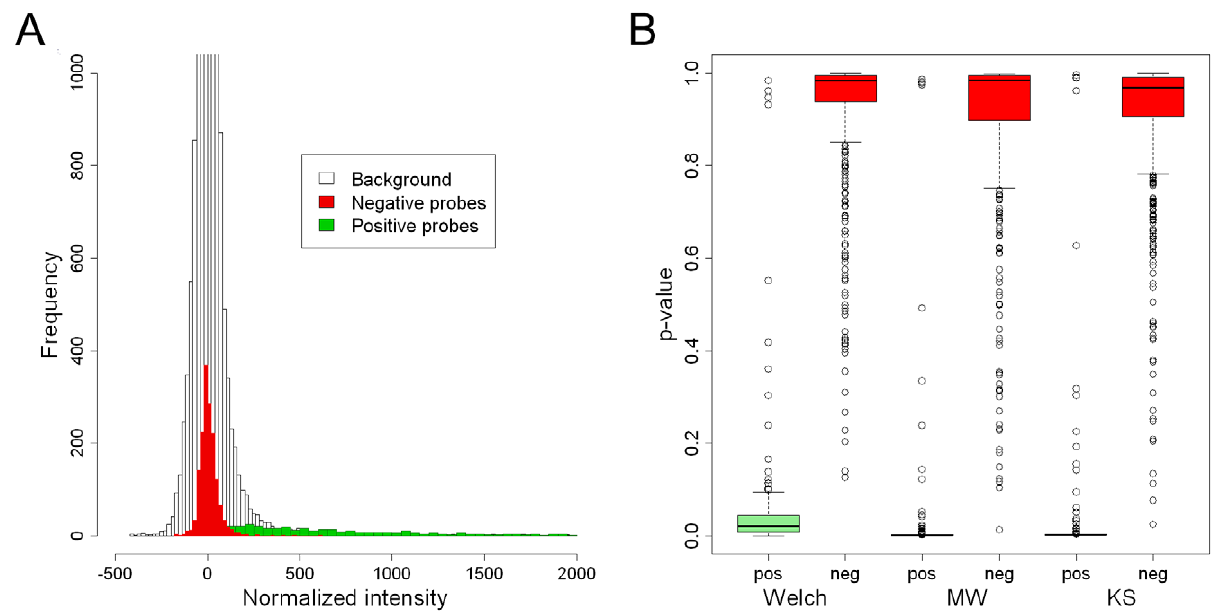
Figure 4. Evaluation of positive and negative microarray signals. A) Distributions of background signals and signals from true positive probes (green) and true negative probes (red). For clarity, frequencies above 1000 and tails of intensity distributions over 2000 are not shown. B) P- value distributions of three statistical tests. Positive (pos) and negative (neg) probes are tested against the background distribution.